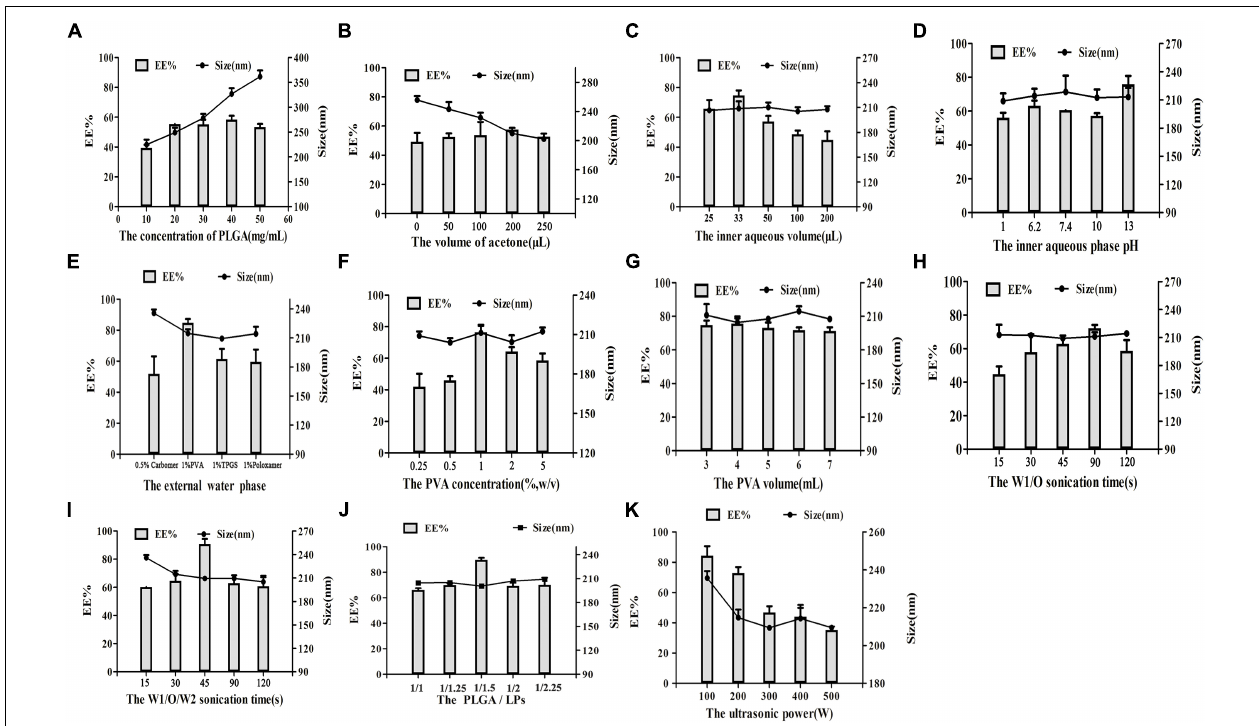
FIGURE 1 | Effect of various processing parameters on the particle size (nm) and EE of YF4-LNPs. (A) The concentration of PLGA, (B) The volume of acetone, (C) The volume of the inner aqueous medium, (D) The pH, (E) The external water phase, (F) The concentration and (G) The volume of PVA, (H) The ultrasonic time of W1/O and (I) W1/O/W2, (J) The ratio of PLGA/LPs, and (K) The ultrasonic power.